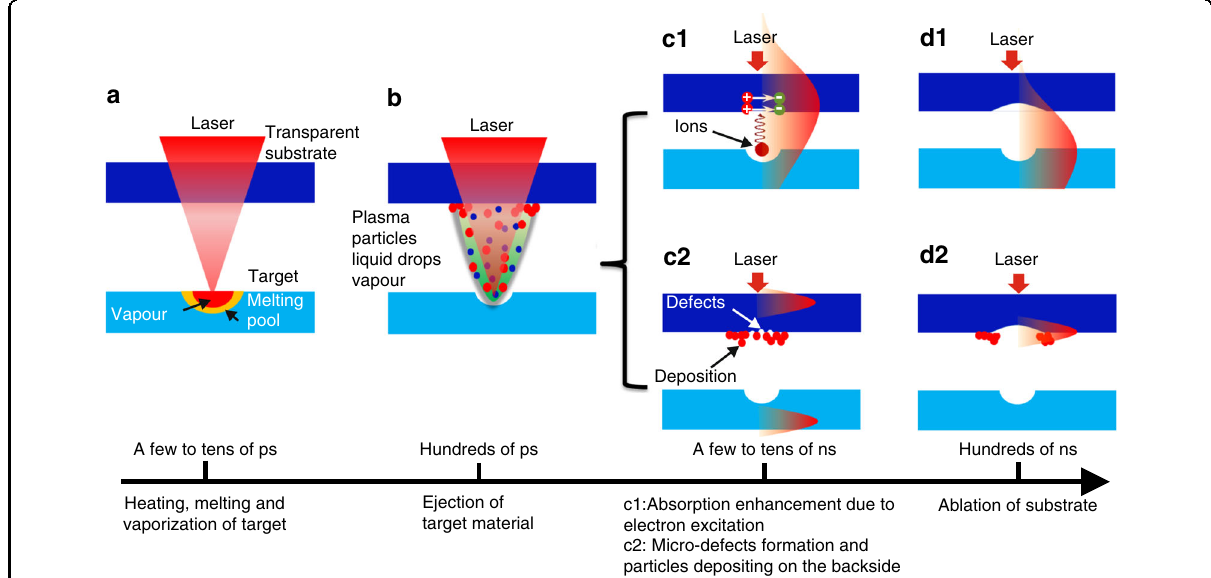
Fig. 3 Schematic illustration of LIPAA process. a Heating effect of the laser irradiation causes localized melting and vaporization. b The laser- induced melting and vaporization lead to the ejection of target materials. c1 , d1 Case1: there is an overlap between the later part of the pulse and the time for absorption enhancement originated from the laser-induced plasma. Laser ablation occurs due to strong absorption enhancement at the rear surface. c2 , d2 Case 2: there is no overlap between the laser pulse and the absorption enhancement. The absorption enhancement from the micro-defects and deposition results in the ablation by subsequent